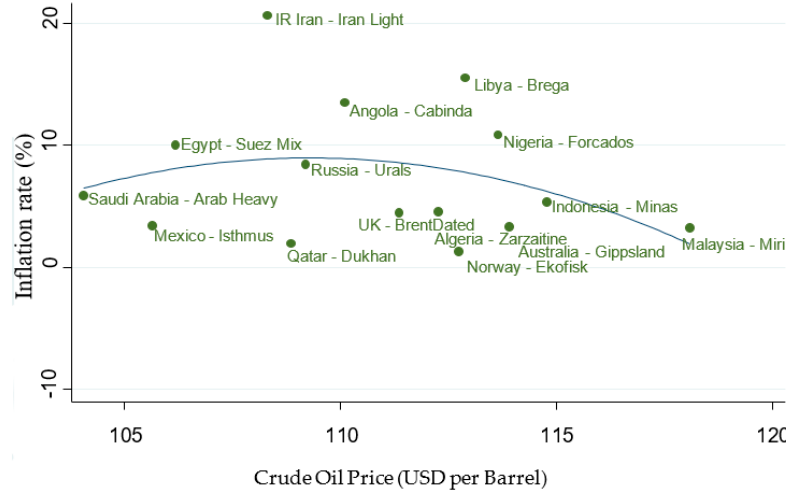
Figure A1. The crude oil price and inflation rates in oil-exporting countries (excluding the United States). Notes: The curve was the best-fit curve to the scatter plot. The shaded area displays the 95% confidence intervals. Source: This graph was plotted by the first author based on the data reported in the OPEC Annual Statistical Report [8] using the Stata Statistical Software Release 13 (StataCorp LP, TX, USA).